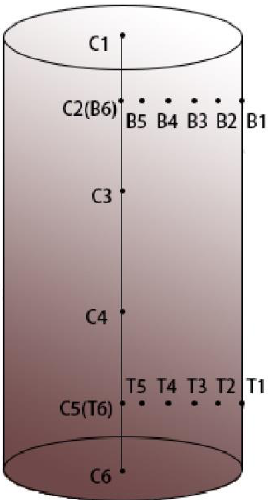
Figure 1. Schematic of the simulated core model.